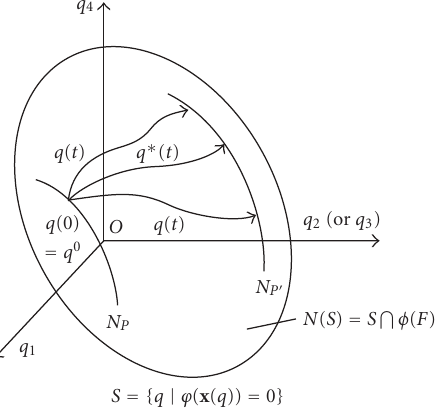
Figure 9: A geodesic curve starting from q 0 lying on N P and reaching some point on N P (cid:5) . Here, φ is a homomorphism mapping F in M to φ ( F ) in R 4